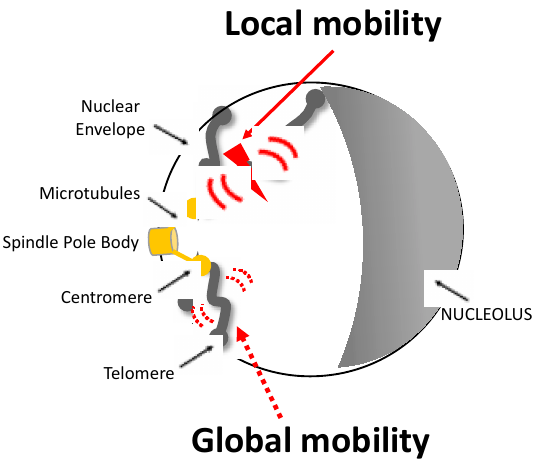
Figure 1. Representation of local and global mobility after a single DSB in a yeast nucleus. The Rabl configuration of a haploid yeast cell is illustrated: chromosomes are attached to the spindle body (SPB) by their centromere (CEN) via a nuclear microtubule (MT) and to the nuclear envelope (NEV) by their telomere (TEL). The induction of a DSB, represented by the red flash, triggers an increase in the mobility of nearby chromatin known as local mobility and that of other chromosomes known as global mobility. Local and global mobility are symbolized by large red and dashed red arrows, respectively.